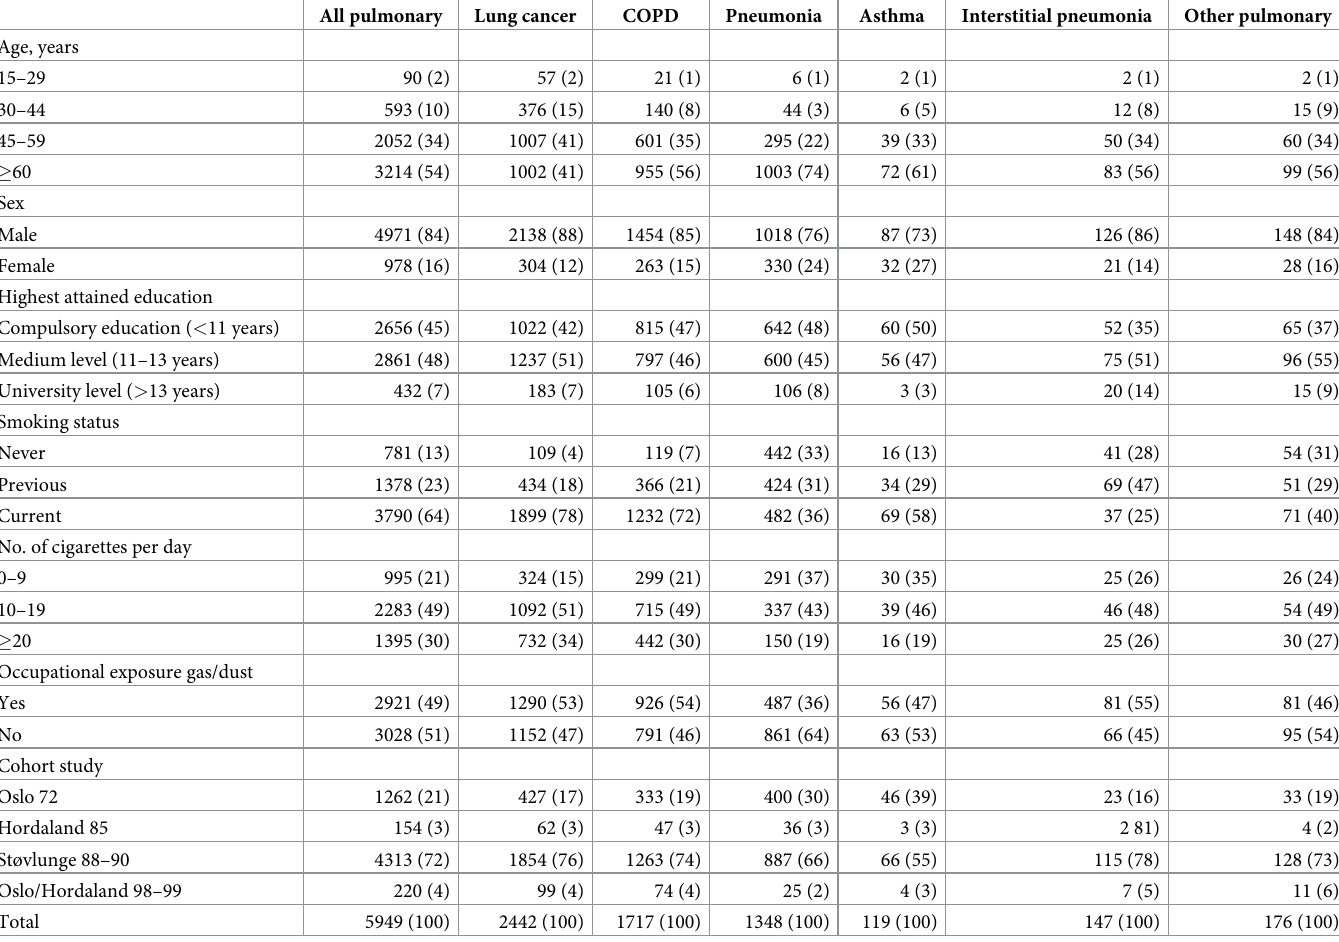
Table 3. Crude number of deaths (%) according to respiratory causes in the pooled cohort � . All pulmonary Lung cancer